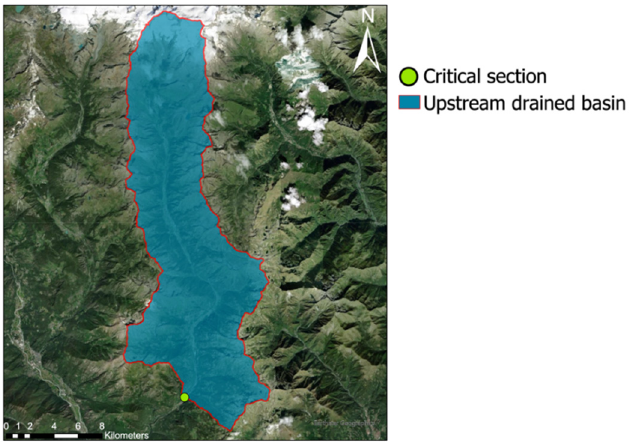
Figure 7. Drained watershed upstream of the critical section identified at the footslope of Theilly landslide.